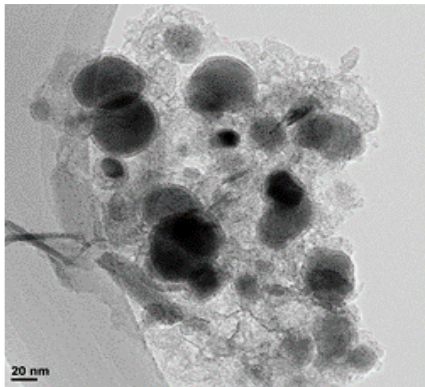
Figure 2. TEM images of carbon-encapsulated nano-zero valent iron (CE-nZVI) detailed structure of core-shell (on the lower left part of the image, the bar shown corresponds to a 20 nm distance in the picture).